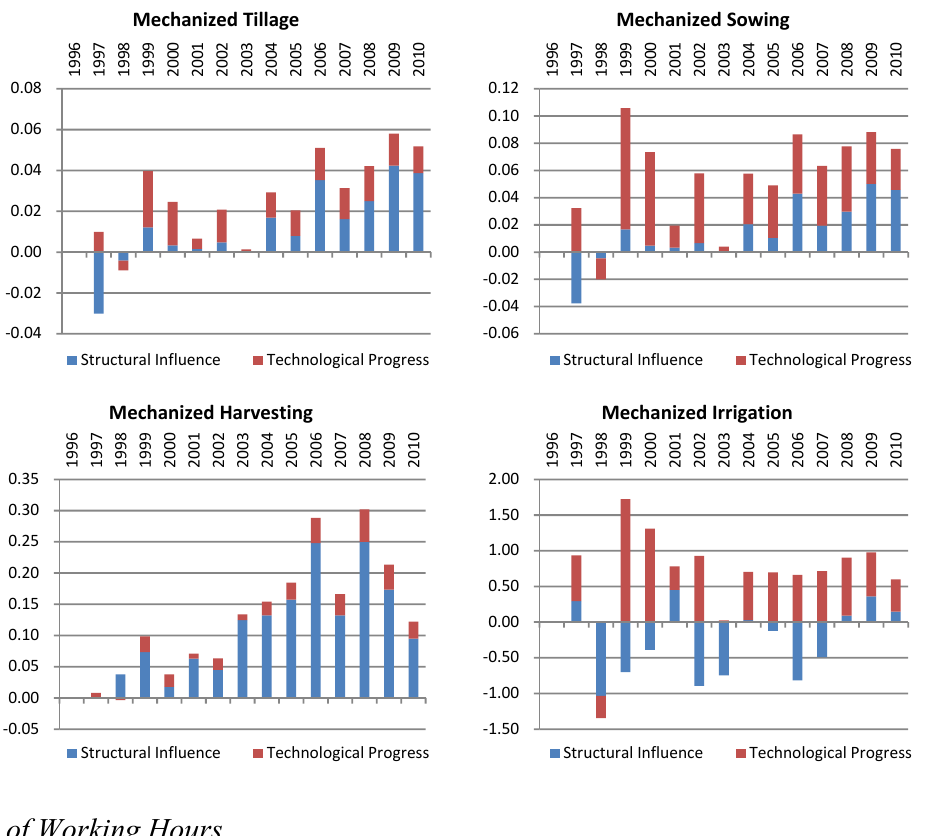
Figure 7. Changes in the unit productivity compared with that in the previous